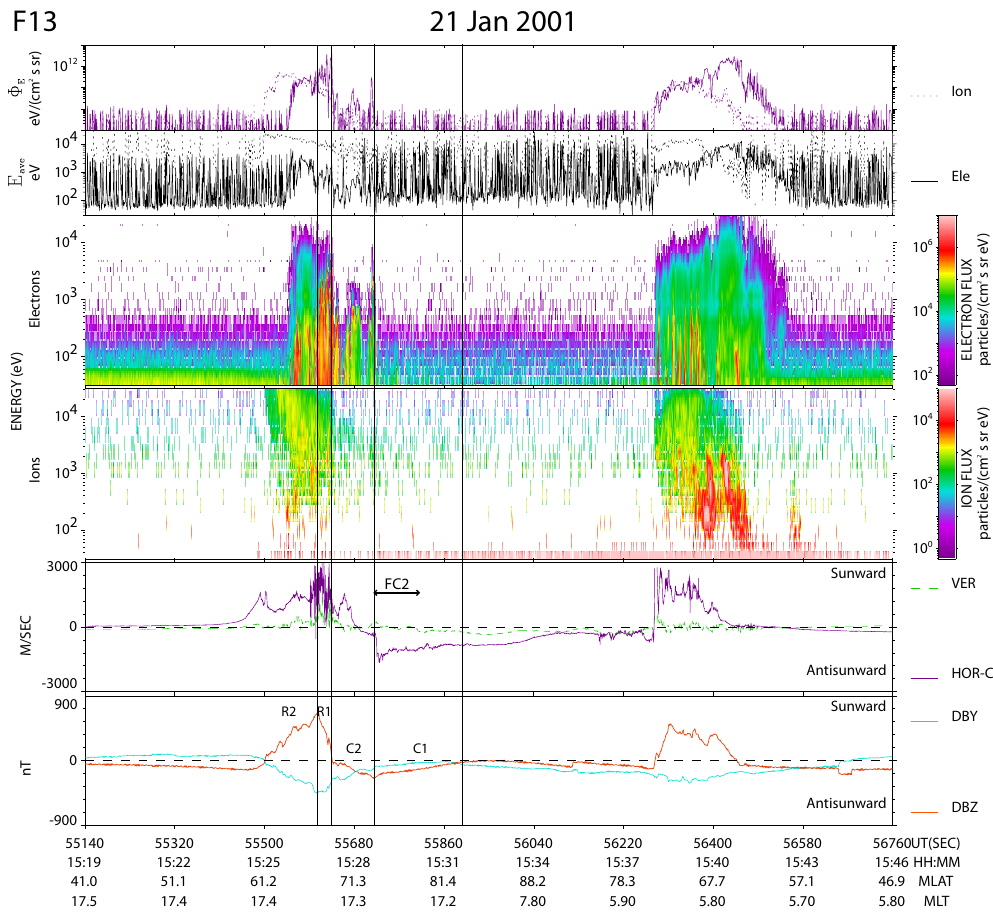
Fig. 3. DMSP F13 data from the NH-dusk/ B y < 0 case during the interval 15:19–15:46UT on 21 January 2001. Panels from top to bottom shows (i) energy fluxes of precipitating ions and electrons, (ii) average energy (ions and electrons), (iii–iv) electron and ion spectrograms (differential energy flux), (v) cross-track horizontal ion drift, and magnetic deflection components B z (east-west) and B y (along track). Different latitude regimes of particle precipitation and Birkeland current (C1-C2-R1-R2) are marked by vertical guidelines. Flow channel FC 2 is indicated in the ion drift panel. From Sandholt et al.